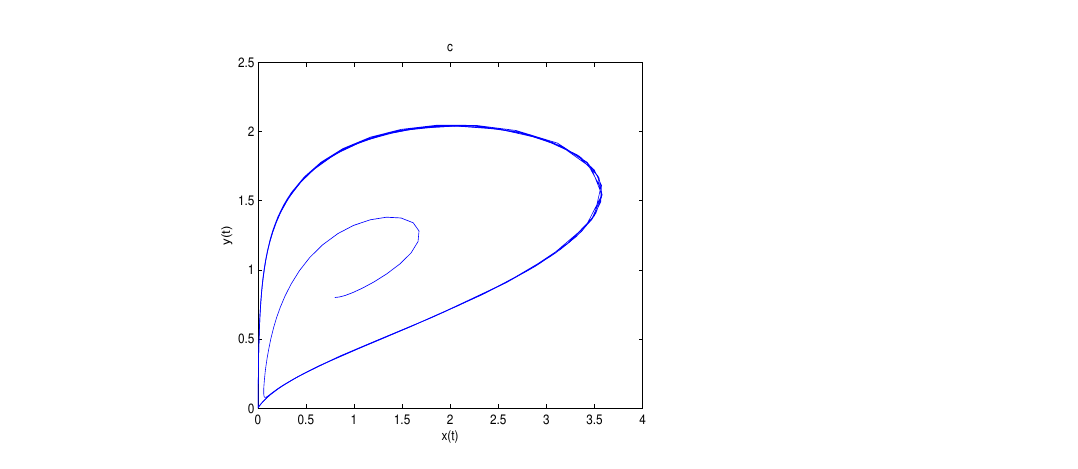
Figure 15. O is a saddle node, and there exists at least one limit cycle near A 5 ( 1,1 ) . In here r = 2, ω = 1, b = 1, c = 2, α = 0.3. Subfigure ( a ) is time series of x ( t ) , subfigure ( b ) is time series of y ( t ) and subfigure ( c ) is phase diagram of system (9).